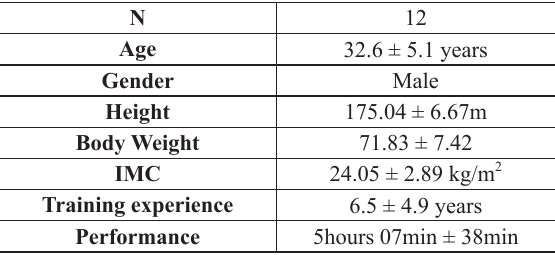
Sample characteristics (N, age, gender), training experience (years) and performance (time spent during the half ironman) in the half